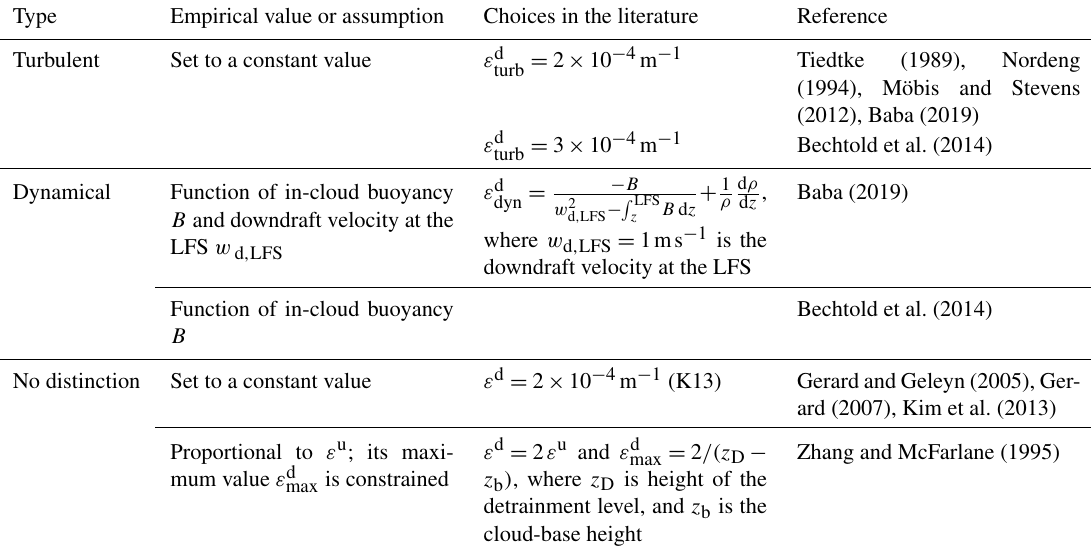
Table 6. A sample of empirical values and assumptions used in the parameterization of entrainment in the downdraft.